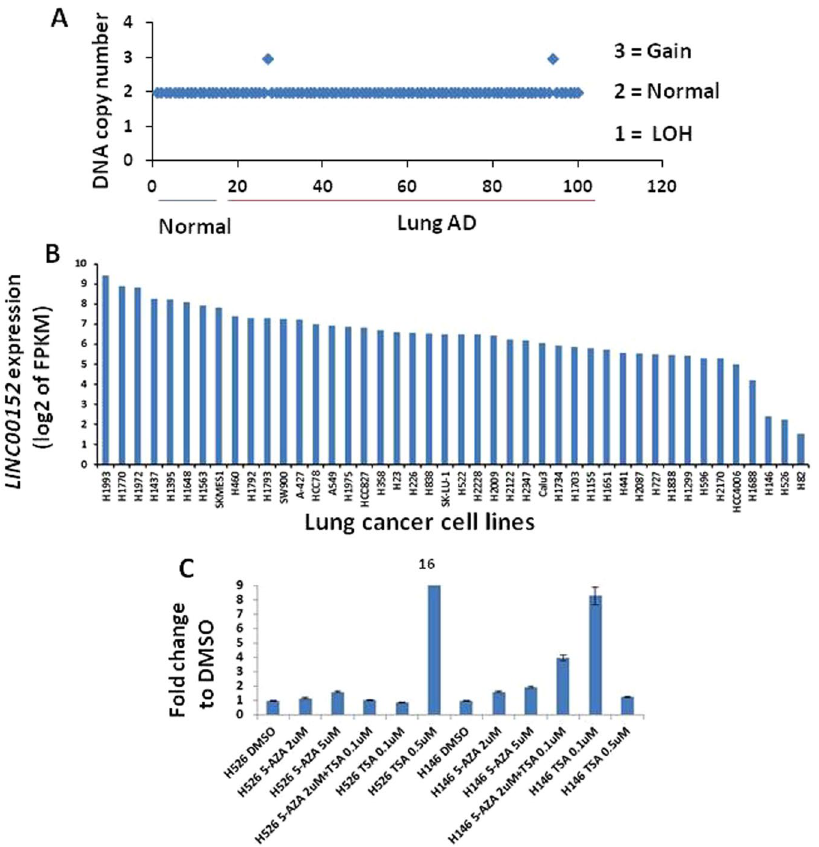
Figure 3. ( A ) No amplification of the LINC00152 region was detected as determined by Affymetrix SNP6.0 analysis of 90 lung adenocarcinomas and 10 normal lung tissues. Two tumors with gains were found. ( B ) LINC00152 maintains a high expression level in most of the non-small cell lung cancer cell lines according to the RNA-Seq data (log2 of FPKM value, p < 0.05), whereas, the three small cell lung cancer cell lines, H526, H146 and H82, have a relative low expression of LINC00152 . ( C ) 5-aza-2-deoxycytidine 5-aza and Trichostatin A (TSA) treatment indicates that deacetylation might result in the low expression of LINC00152 in H146 and H526